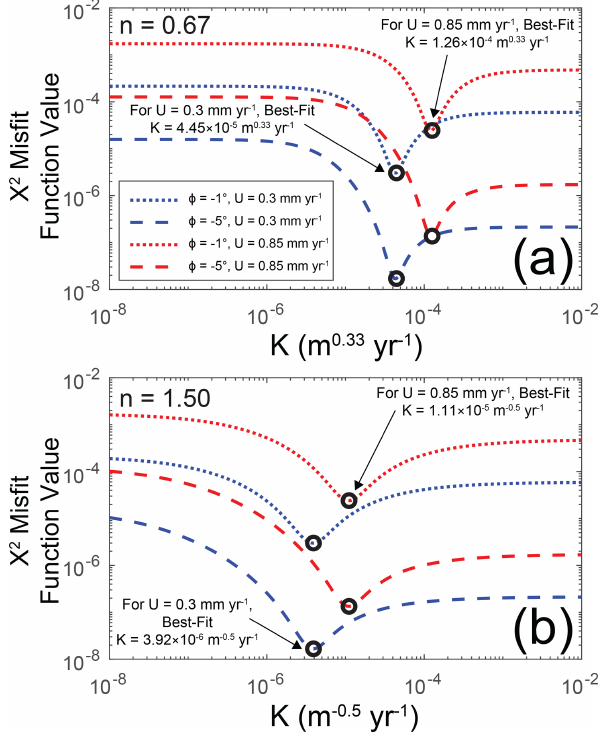
Figure 16. X 2 misfit function values for kinematic wave speed ( C H ) estimates made with Eq. (12) and a wide range of erodibility ( K ) values relative to the C H estimated for Tank Wash with Eq. (13) (Fig. 15). Panel (a) shows results for n = 0 . 67, while panel (b) shows results for n = 1 . 5. Also note that the X 2 values are lower for φ = − 5 ◦ because a greater dip in the upstream direc- tion causes a smaller range of kinematic wave speeds (e.g., Fig. 9c). The misfit for this reduced range can be smaller, but these lower X 2 values do not indicate that the dip is closer to − 5 ◦ than to − 1 ◦